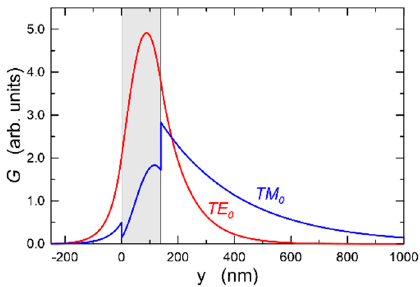
Figure 15. Modal characteristics of the slab waveguide. n b -n 1 -n c = 1.51-1.94-1.00, λ = 677 nm.